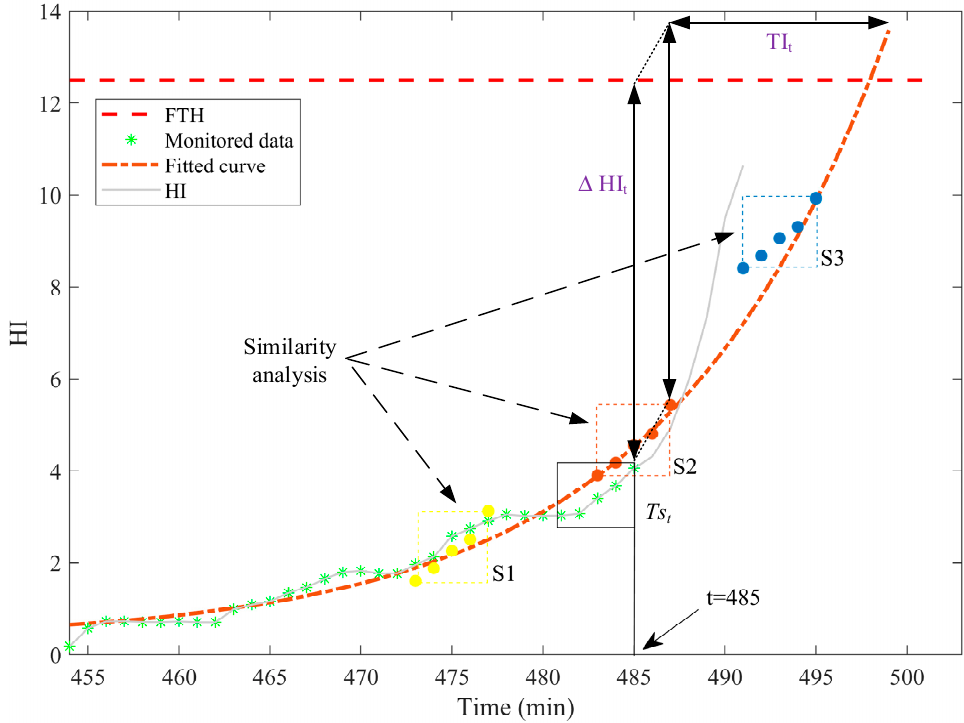
Figure 2. The schematic diagram of TTF prediction using the proposed method.